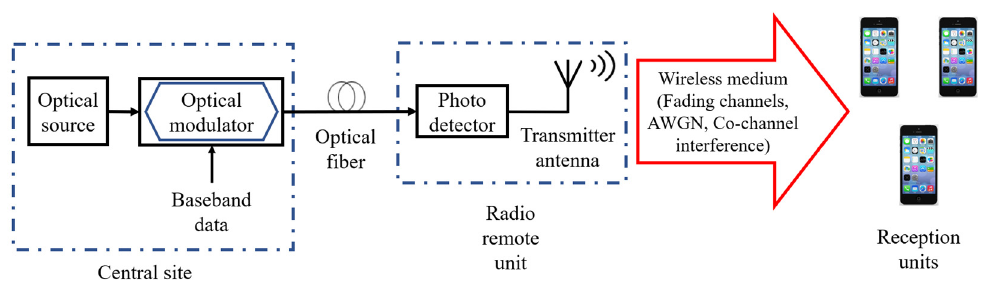
Figure 1. Basic fiber-radio scheme.